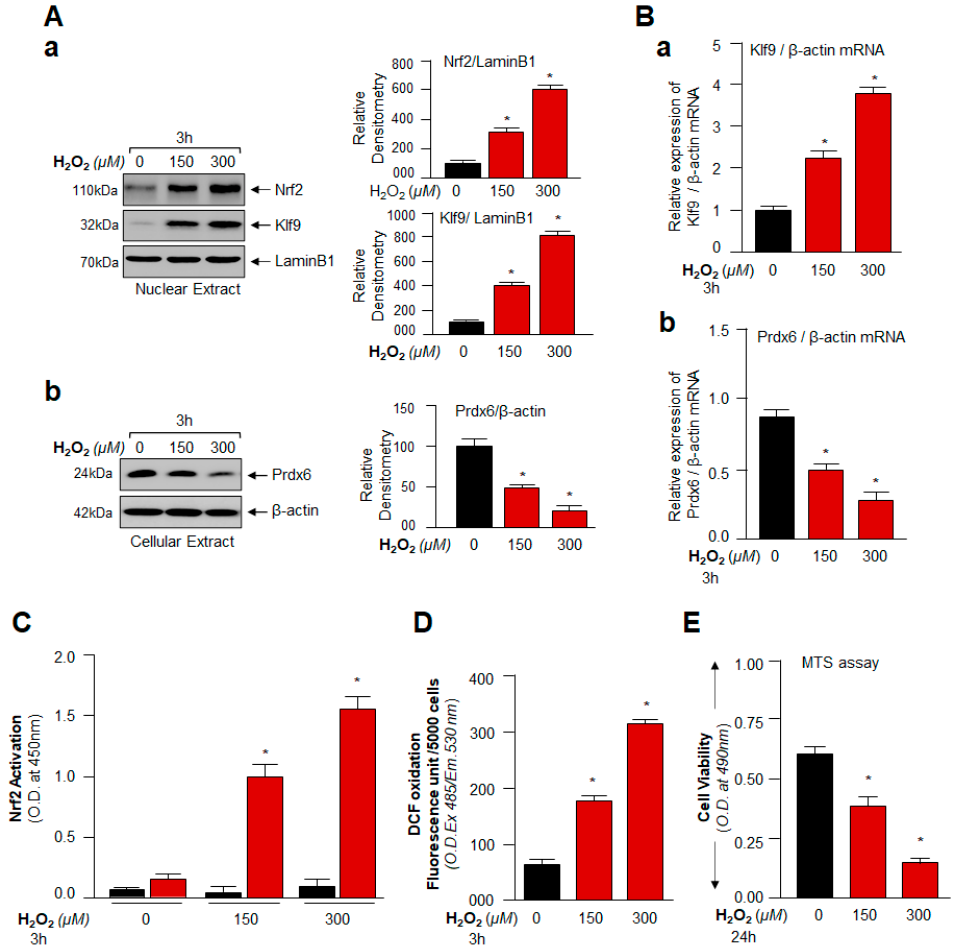
Figure 3. Aberrant Nrf2 and Klf9 expression by excessive oxidative stress was associated with reduced Prdx6 repression, ROS accumulation and increased cell death. ( A ) Cellular and nuclear extract were prepared from hLECs exposed to increasing doses of H 2 O 2 as indicated in Figure. Samples containing equal amount of protein were immunoblotted using antibody specific to Nrf2 or Klf9 or LaminB1 or Prdx6 or β -actin as shown, and an increased nuclear accumulation of Nrf2 and Klf9 ( Aa ) and reduced in Prdx6 expression ( Ab ) were observed in response to the increased concentrations of H 2 O 2 treatment. Right adjacent panel reveals densitometry analysis of each protein bands. ( B ) hLECs were exposed to different concentrations of H 2 O 2 . 3 h later total RNA was isolated. Real-time qPCR analysis of Klf9 ( Ba ) and Prdx6 ( Bb ) with their corresponding specific primers. Data are the mean ± S.D. value of three independent experiments. * p < 0.001 versus control. ( C ) H 2 O 2 treated hLECs showed a significant increase in Nrf2 activity. hLECs were treated with different concentrations of H 2 O 2 for 3 h, and nuclear extract were analyzed for Nrf2-ARE (antioxidant responsive element) binding by ELISA (enzyme-linked immunosorbent assay). Nuclear extracts containing equal amount of protein were processed and assayed for Nrf2 activity with a commercially available kit (Active motif) as described in Materials and Methods. The data represent the mean ± S.D. from three independent experiments. p values were determined; H 2 O 2 treated versus untreated control. * p < 0.001. Note: to avoid effect of cell death against excessive